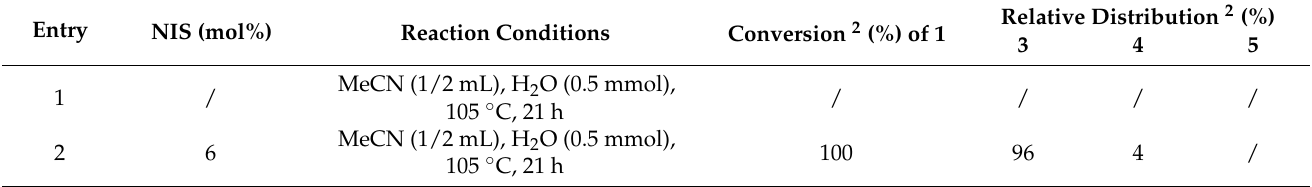
Table 1. Optimal reaction conditions for the highest conversion of diphenylmethanol 1 into the N -benzhydrylacetamide 3 mediated by NIS 1 .